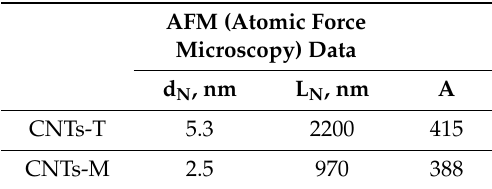
Table 1. Diameter, length and aspect ratio (A) of carbon nanotube bundles (CNTs-T and CNTs-M) in